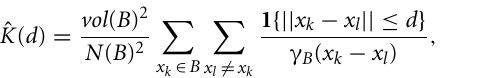
junctions in the box. We repeated this process 50 times for each layer. The dimensions of the box were the same for all layers, and it had the maximum volume that could be extracted from all the samples, i.e., it had the minimum length in each dimension (x, y, z) considering all